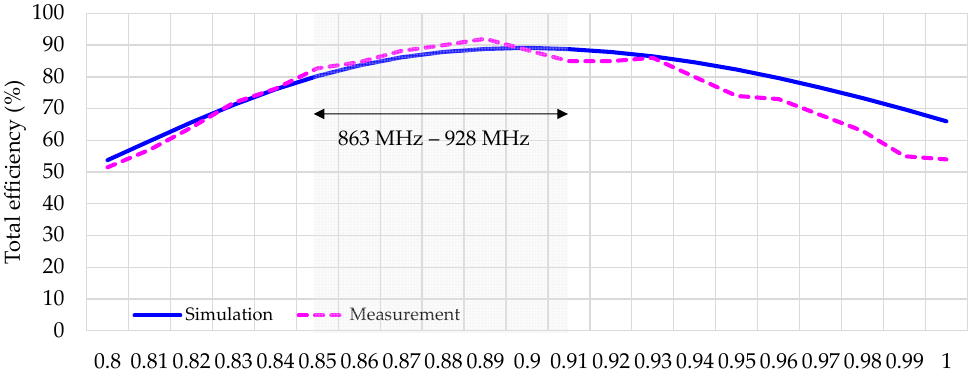
Figure 5. Simulated and measured total efficiency η t for the antenna booster on a 120 mm × 60 mm ground plane. Total efficiency was measured in an anechoic chamber (MVG Startlab-18) using 3D pattern integration.